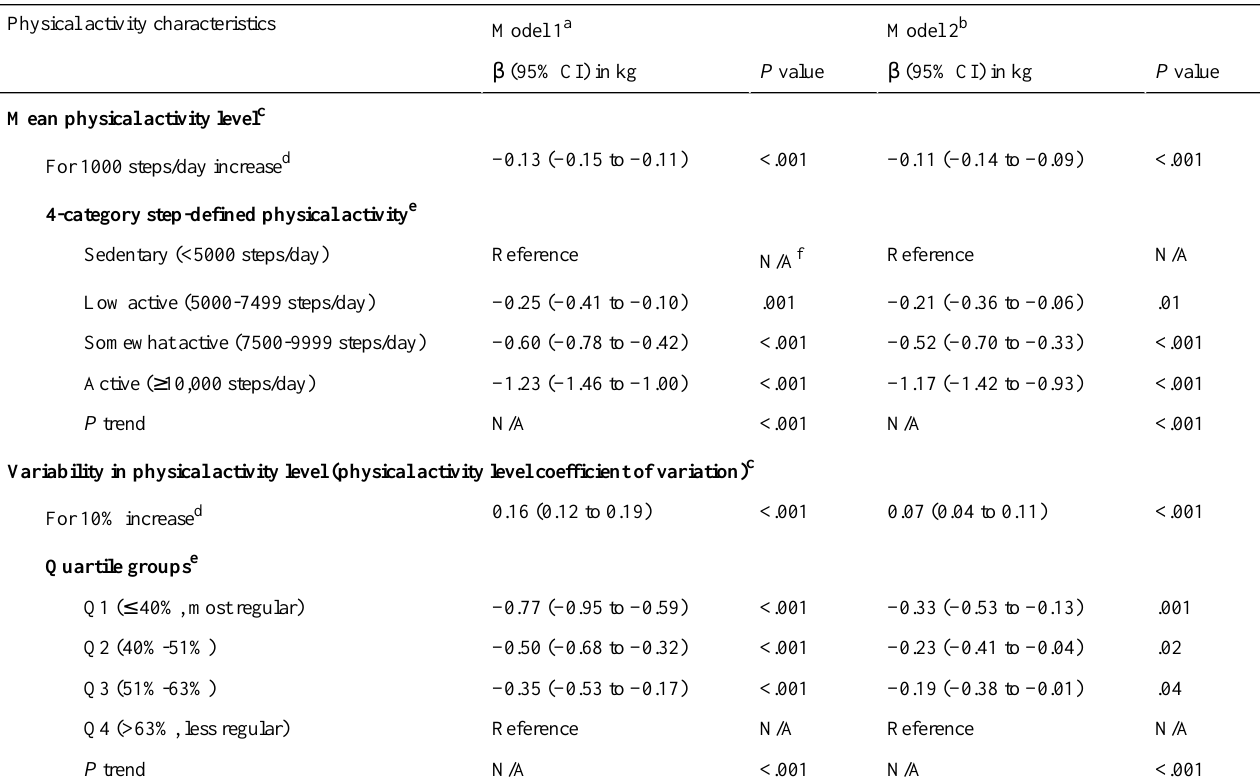
Table 2. Associations of mean physical activity level and variability in physical activity level with 6-month weight change